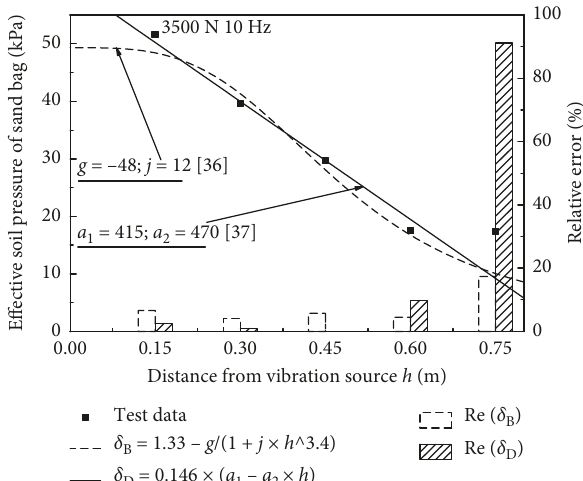
Figure 17: Test results and empirical formulae at different measurement points in the case of three jacks (sand